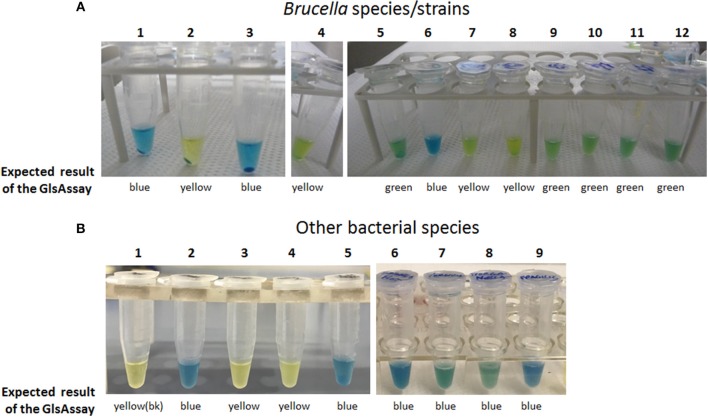
The GlsAssay tested on different bacterial species/strains. (A) The GlsAssay was performed starting form colonies on TS plate of the following Brucella species/strains: (1) B. microti CCM4915 (wild type), (2) B. microti CCM4915 ΔglsA, (3) B. microti CCM4915 ΔglsA carrying plasmid pBBR-glsA_Bm, (4) B. abortus ATCC23448 (wild type), (5) B. abortus ATCC23448 carrying plasmid pBBR-glsA_Bm, (6) B. inopinata BO1, (7) B. melitensis 16M, (8) B. ovis ATCC25840, (9) B. neotomae 5K33, (10) B. suis 1330, (11) B. suis S4, (12) B. canis RM16/66. (B) The GlsAssay was performed starting form liquid cultures (picture on the left) or from colonies (picture on the right) of the following bacterial species: (1) GlsAssay solution (blank), (2) E. coli MG1655 wild type, (3) E. coliΔybaS, (4) Salmonella typhimurium LT2, (5) Yersinia ruckeri ATCC29473, (6) Shigella flexneri CIP52.36, (7) Yersinia enterocolitica, (8) Morganella morganii morganii CIP A236, (9) Bacteroides fragilis CIP77.16. The incubation was carried out at 37°C for 2–3 h.